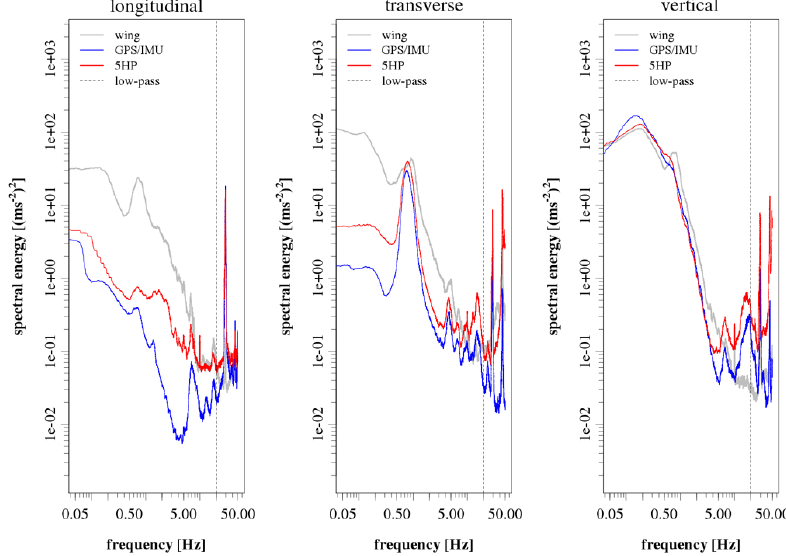
Fig. 1. Smoothed power spectra of acceleration measurements in the WSMA trike coordinate system. The dashed vertical line indicates the −